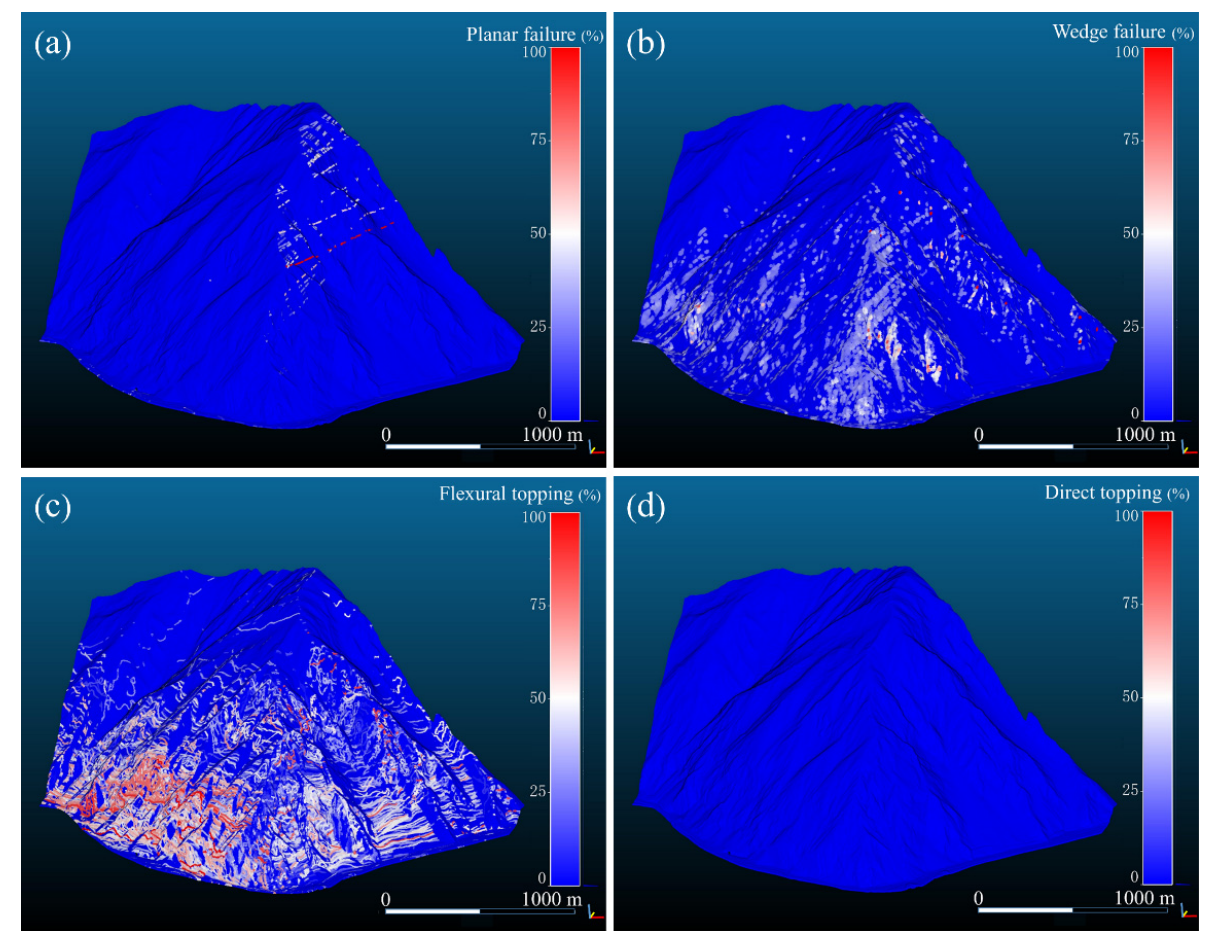
Figure 11. Results of ROKA kinematic analysis of possible failure modes using ALS points of the investigated rock slope. ( a ) Planar failure; ( b ) wedge failure; ( c ) flexural toppling; ( d ) direct toppling.